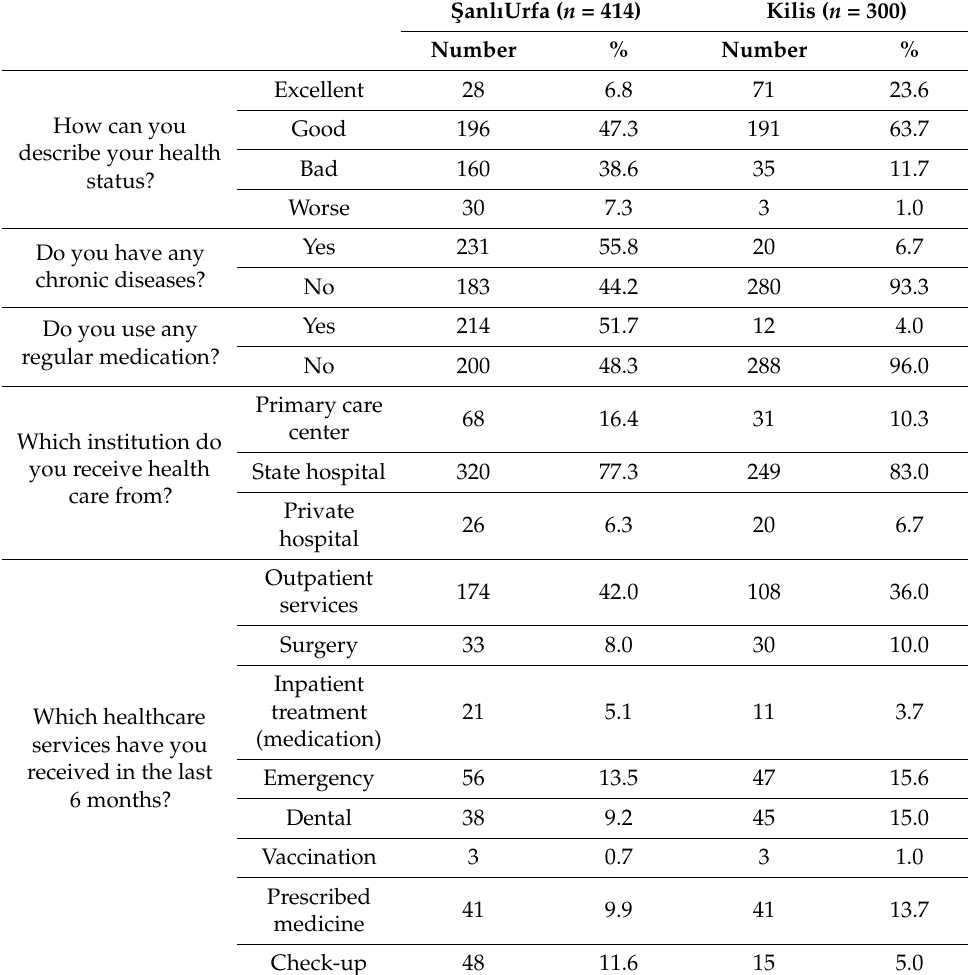
Table 2. Questions about health status and access to healthcare services.